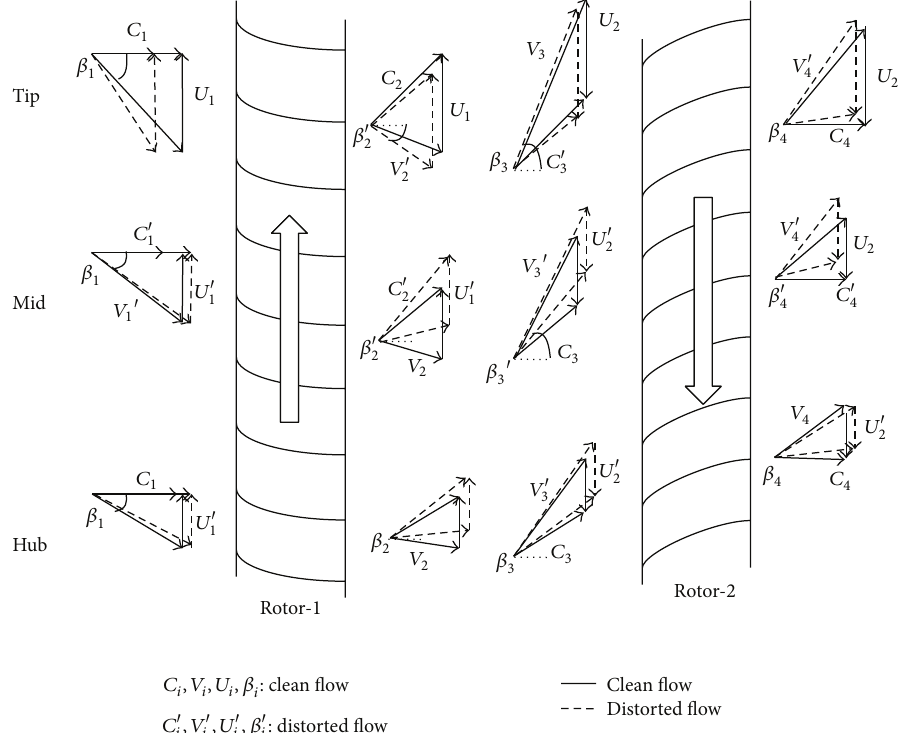
Figure 18: Velocity triangles along the span under tip-strong radial distortion